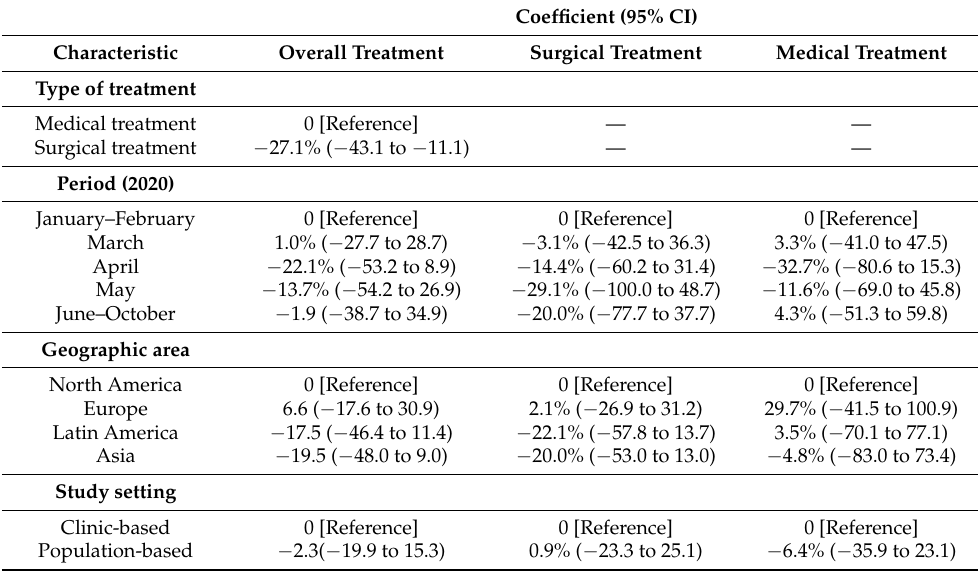
Table 3. Adjusted differences based on multivariate linear analysis for overall, surgical, and medical cancer treatments by type of treatment, period, geographic area, and study